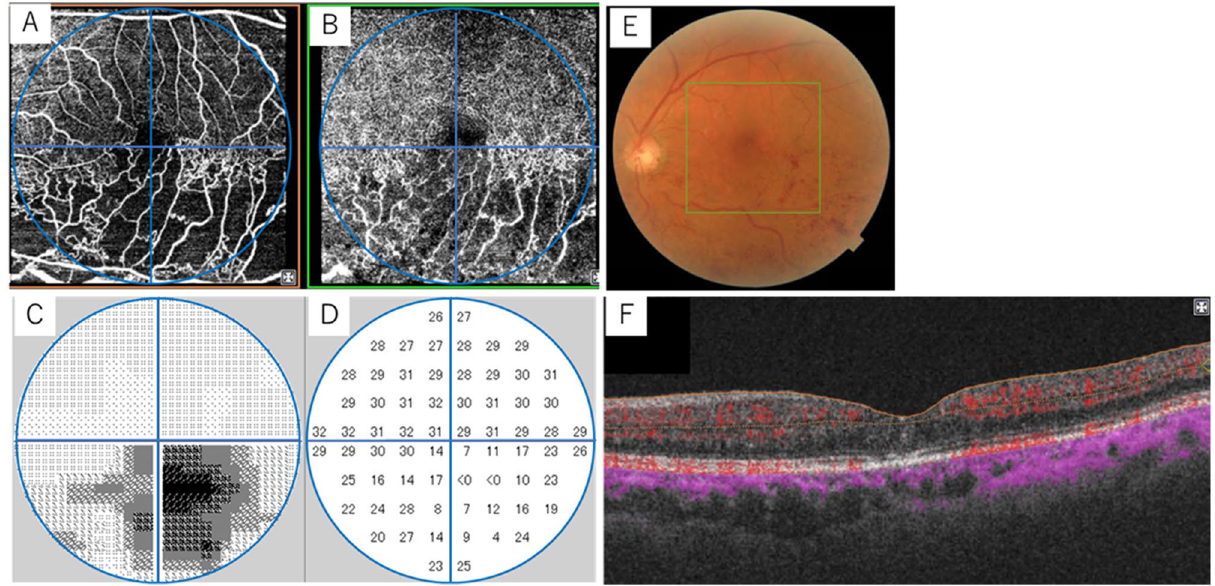
Figure 3. The representative case is the left eye (visual acuity, 20/32) of an 80-year-old male patient 12 months following treatment with four injections of intravitreal aflibercept for supero-temporal major branch retinal vein occlusion. Upside-down images of 6 × 6 mm optical coherence tomography angiography in the superficial capillary plexus ( A ), deep capillary plexus ( B ), and colour fundus photograph ( E ). ( C ) represents the grey scale of the Humphrey visual field analyser 10-2 programme, and ( D )represents the measured threshold. F shows the swept-source optical coherence tomography image with complete oedema absorption. In OCT angiography, these areas are represented as m-NPA, but the visual field sensitivity does not point to uniformly absolute scotomas, indicating varying sensitivity. m-NPA macular non-perfused areas, OCT optical coherence